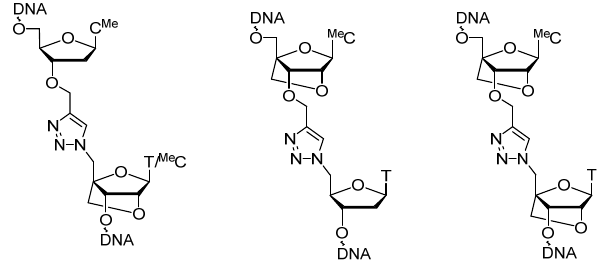
Figure 10. Triazole-linked DNA and LNA